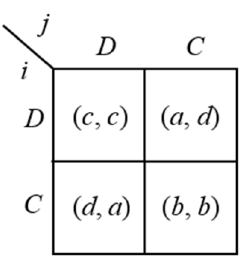
Figure 9. Prisoner’s Dilemma as original game G